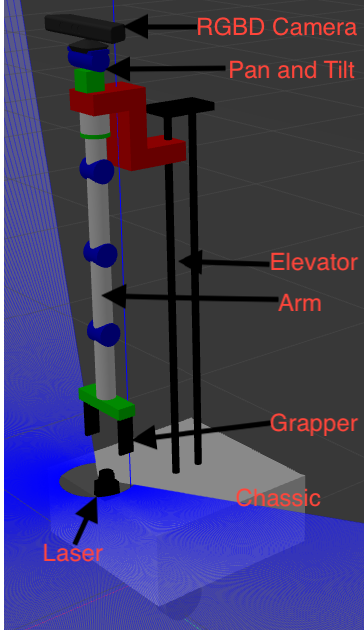
Figure 5. The model of